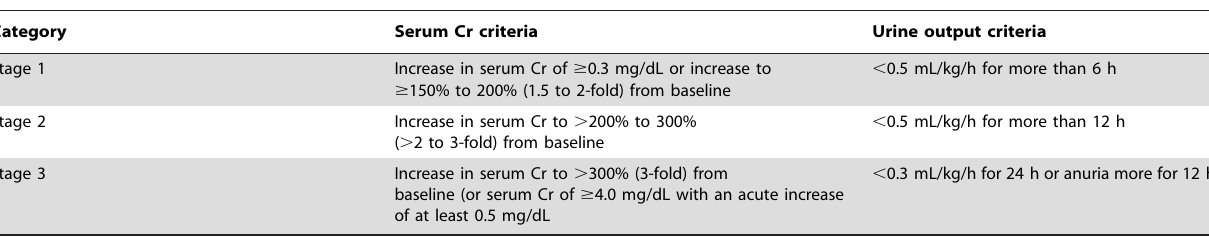
Table 2. AKIN scoring